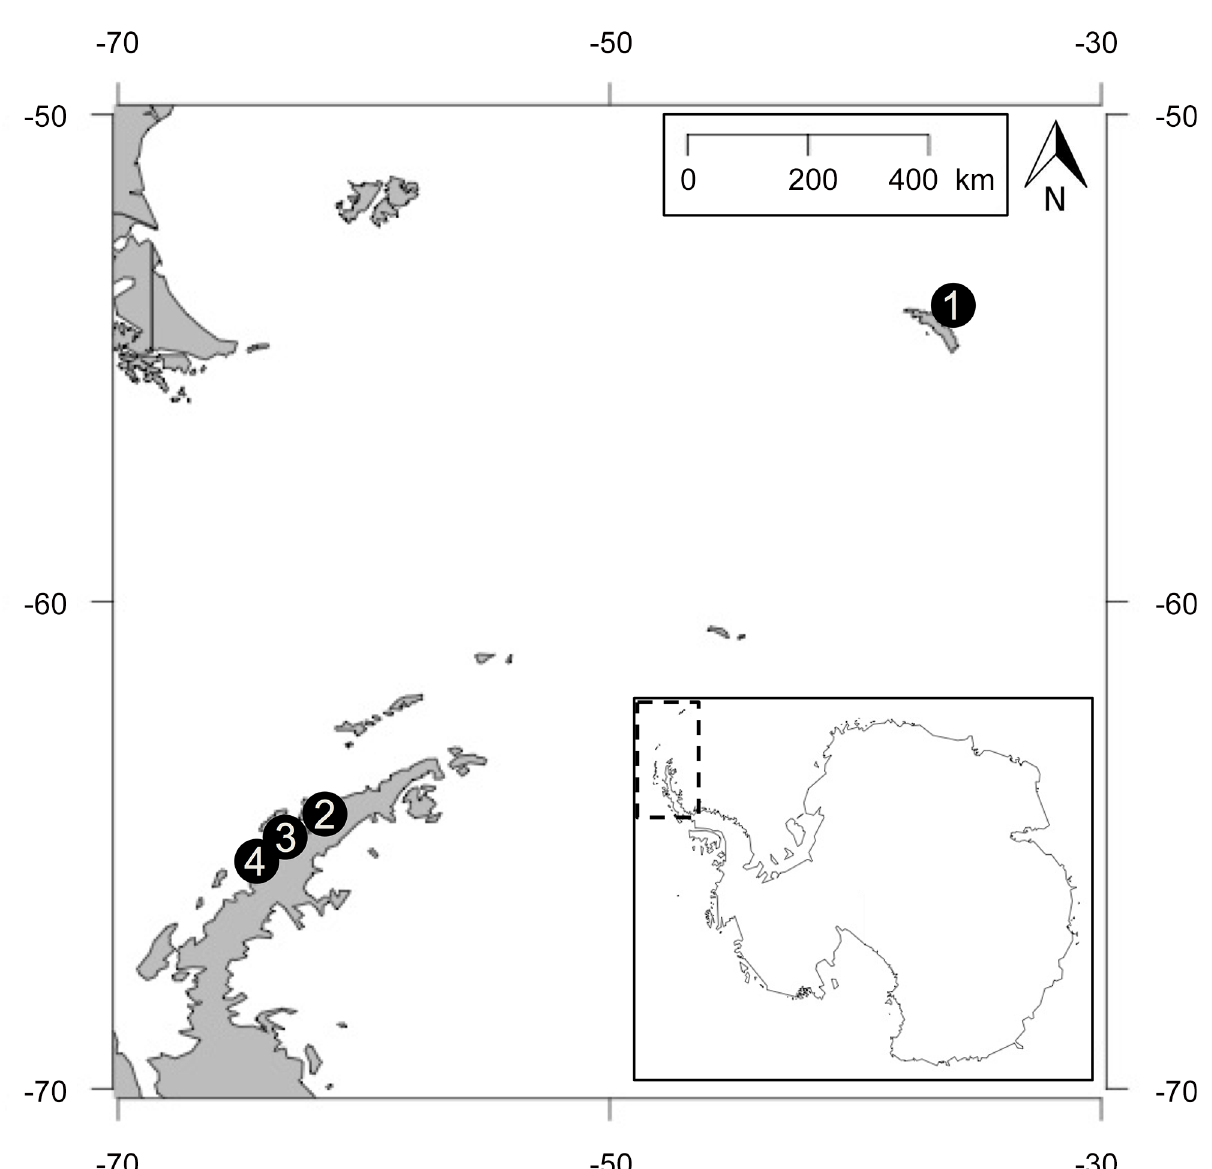
Fig 1. Map of studied gentoo penguin colony locations along a latitudinal gradient ranging from 1) Maiviken, South Georgia to 2) Georges Point, 3) Port Lockroy, and 4) Petermann Island on the Antarctic Peninsula.